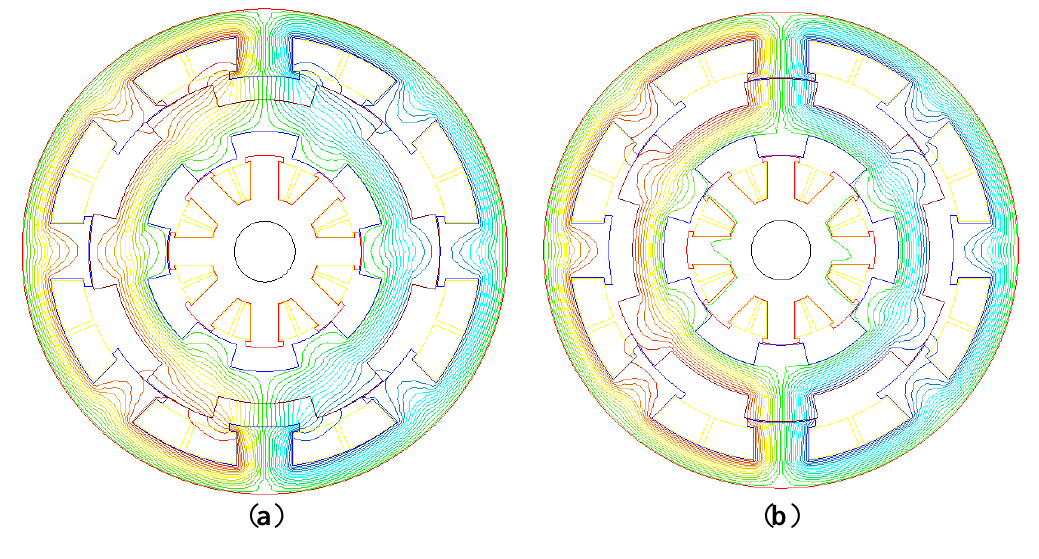
Figure 8. Magnetic line distributions: ( a ) Outer rotor unaligned position; ( b ) Outer rotor aligned